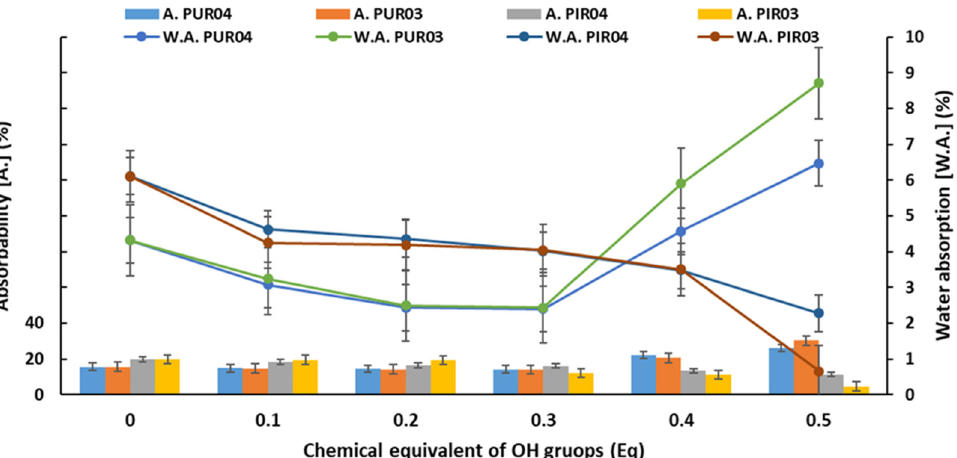
Figure 9. Dependence of absorbability (A.) and water absorption (W.A.) on the content of eco-polyols based on PLA waste.